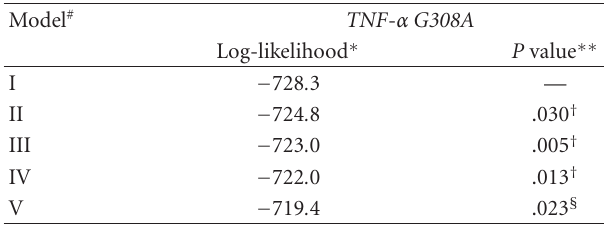
Table 2: Triad counts in control group and case group by genotype. Mating-